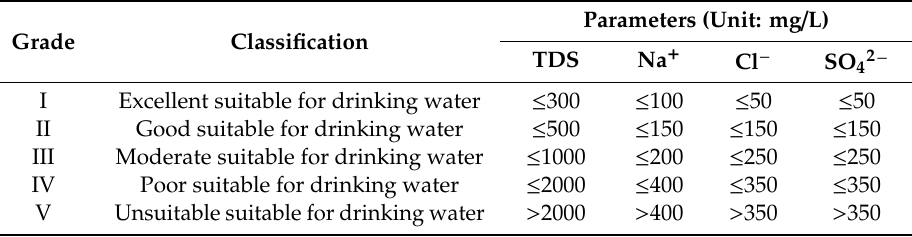
Table 1. Groundwater quality classification based on the Chinese national standard (GB / T 14848-2017). TDS: total dissolved solids. Parameters (Unit: mg / L) Grade Classification TDS Na + Cl − SO 42 − I Excellent suitable for drinking water ≤ 300 ≤ 100 Good suitable for drinking